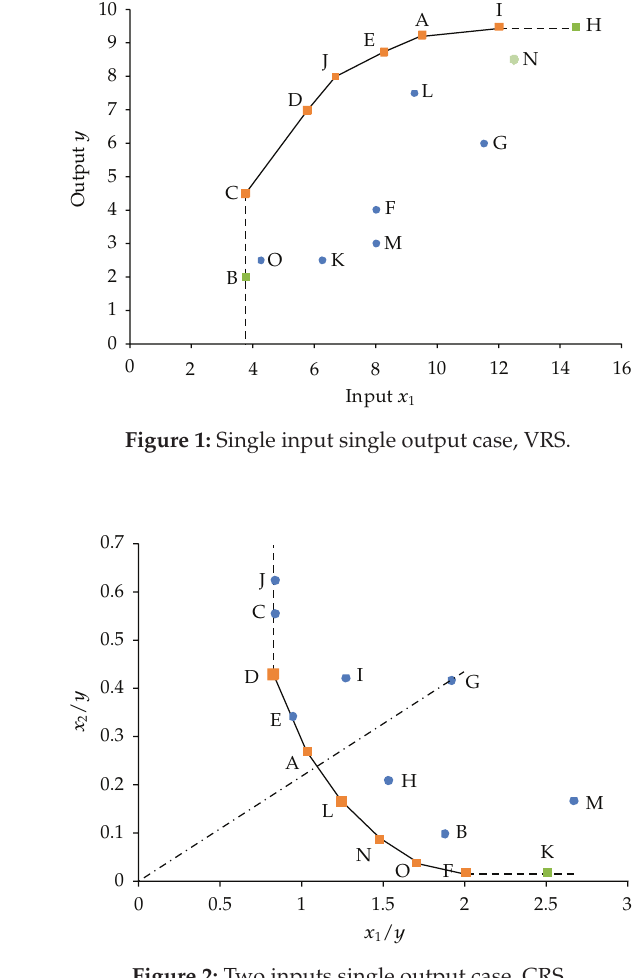
Figure 2: Two inputs single output case,